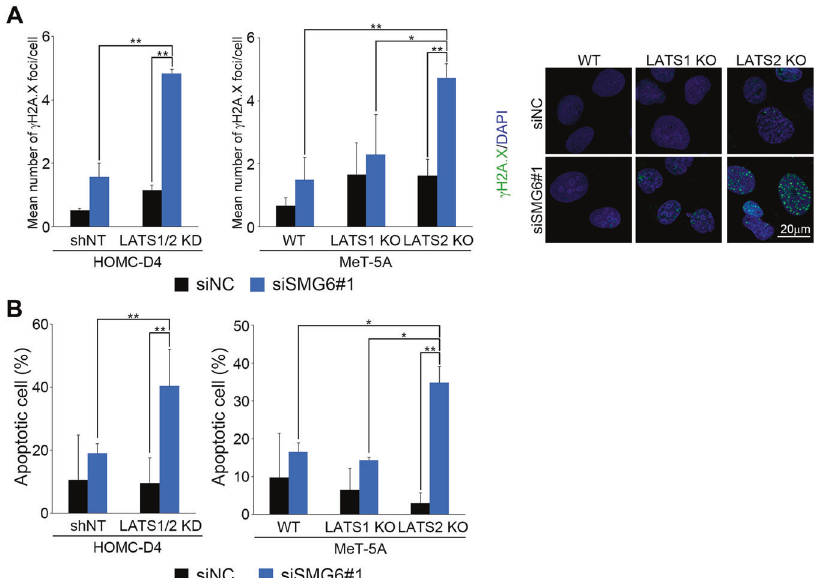
Fig. 3 Knockdown of SMG6 induces DNA damage and apoptosis in LATS2-inactive mesothelial cells. A γ -H2A.X immuno fl uorescence and DAPI staining in various cells infected with control or SMG6-speci fi c siRNA (siSMG6#1). The number of γ -H2A.X foci in each cell was counted 72 h after siSMG6 treatment. γ -H2AX is green, and DAPI is blue. B The number of apoptotic cells was measured by fl ow cytometry using APO- Direct Kit 72 h after siSMG6 treatment. All experiments were performed at least three independent times. Data are presented as means ± SD; p -values were calculated using the Tukey-Kramer method. * indicates p < 0.05 and ** indicates p <